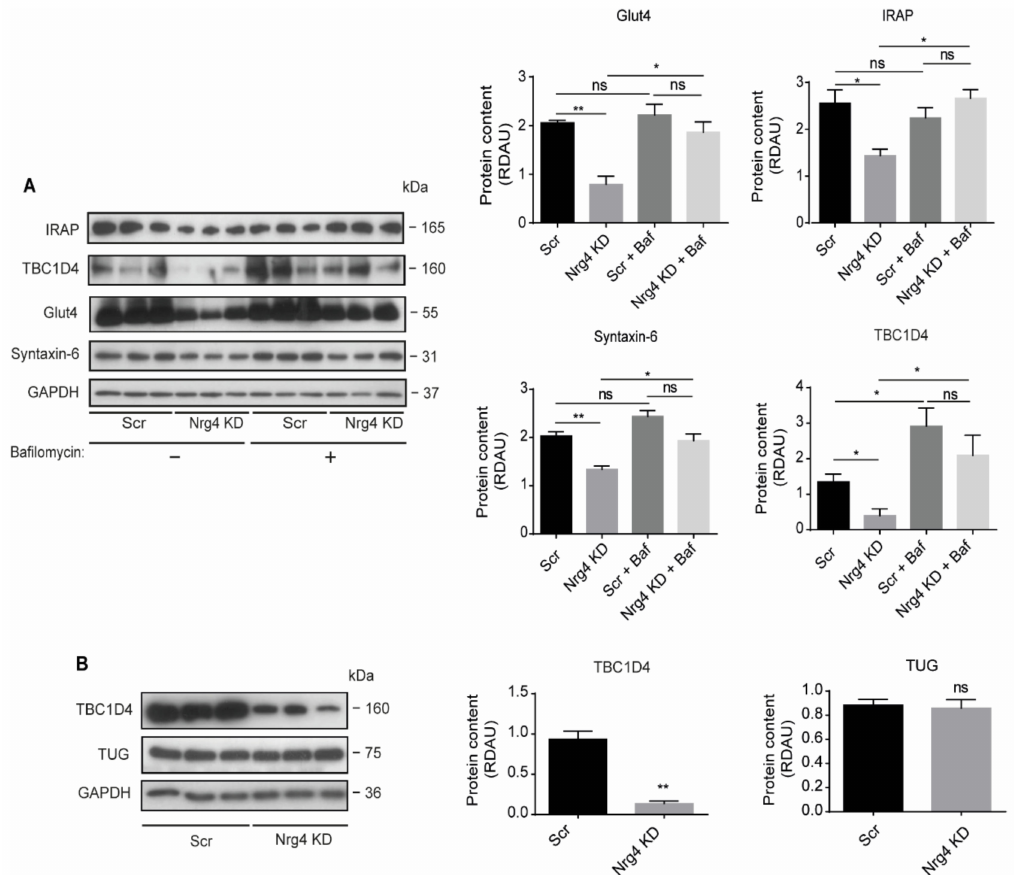
Figure 7. Depletion of Glut4 and GSV-associated proteins in Nrg4 knockdown adipocytes is caused by autophagy degra- dation. ( A ) Adipocytes were treated with 200 nM bafilomycin A1 for 2 h. Western blot bands and quantification of IRAP, TBC1D4, Glut4, and Syntaxin-6 proteins in non-treated and bafilomycin A1-treated Scr and Nrg4 KD adipocytes at day 7 (D7) of differentiation ( n = 3). ( B ) Representative western blot and quantification of TBC1D4 and TUG in Scr and Nrg4 KD adipocytes at D7 ( n = 3); GAPDH was used as a loading control. Each lane of the blots represents an independent experiment. Overall contrast and brightness of the whole western blots were adjusted to clarify the images. Data represent mean ± SEM. * p ≤ 0.05, ** p ≤ 0.01, ns (not significant). For the statistical analysis of the graph in panel 7D graph, t -tests were used to analyze the statistical differences between